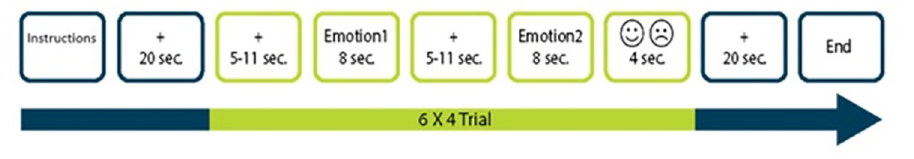
Fig 2. The design of the Emotional Shifting